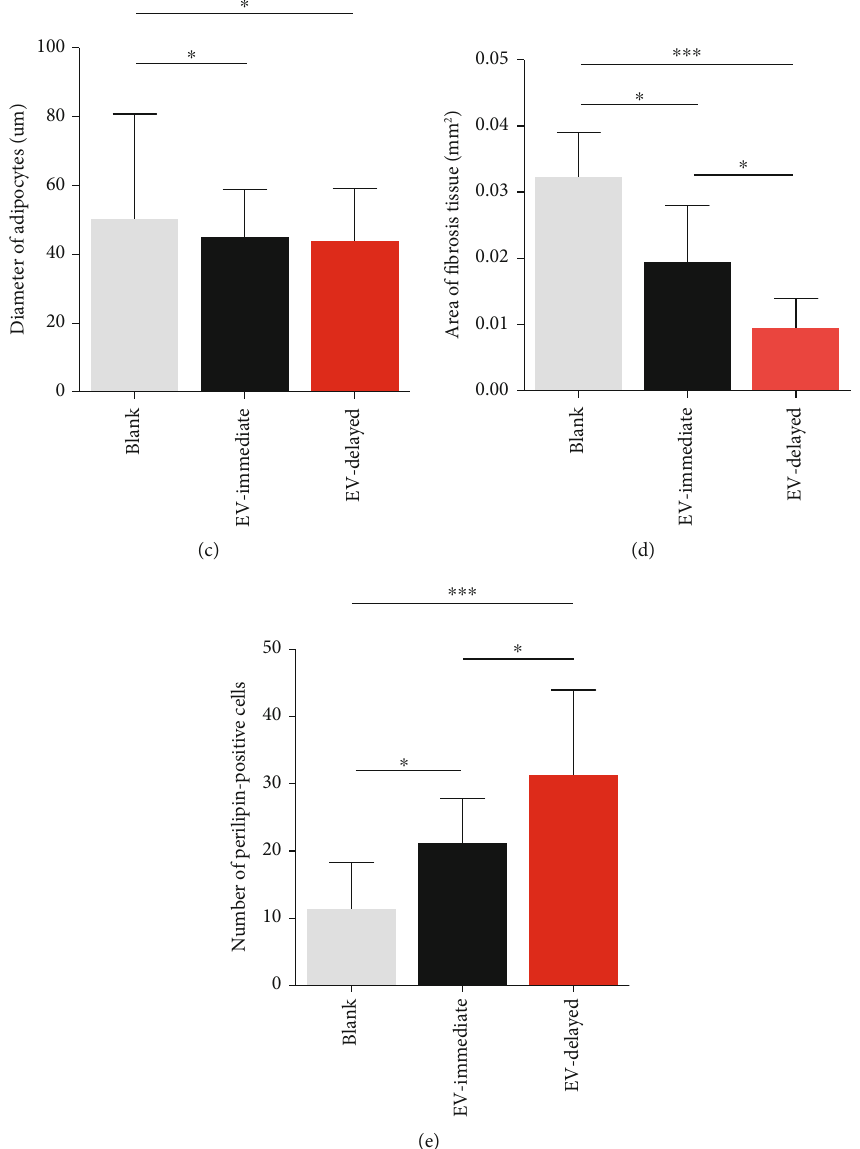
Figure 5: Histological evaluation and immuno fl uorescence staining of fat grafts after 3 months of transplantation. (a) H&E-stained pictures (low magni fi cation and high magni fi cation) and (b) immuno fl uorescence stained images (perilipin: green fl uorescence) of grafts slices taken from three groups at month 3. Black arrows represent fi brosis and black hexagrams indicate vacuoles. White hexagrams show perilipin- negative crown-like structures. Quantitative analysis of (c) diameter of adipocytes, (d) area of fi brosis tissue, and (e) number of per perilipin-positive cells. ∗ P < 0 : 05 and ∗∗∗ P < 0 : 001